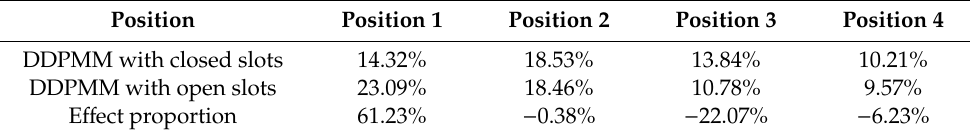
Table 3. Total harmonics distortions (THDs) of air-gap flux density at di ff erent positions.